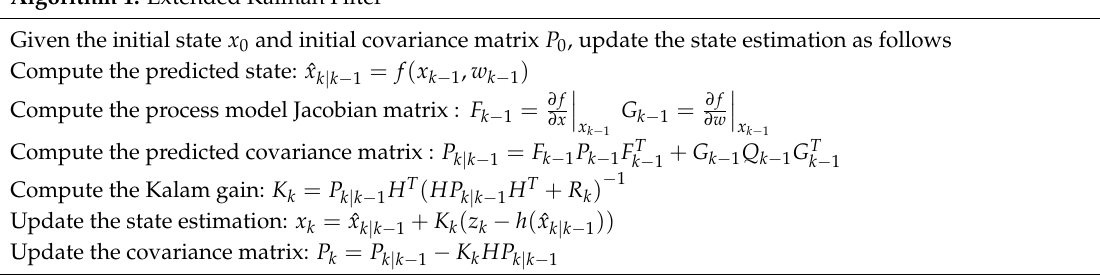
Table 6. Comparison of experiment results under three sets of PD parameters.